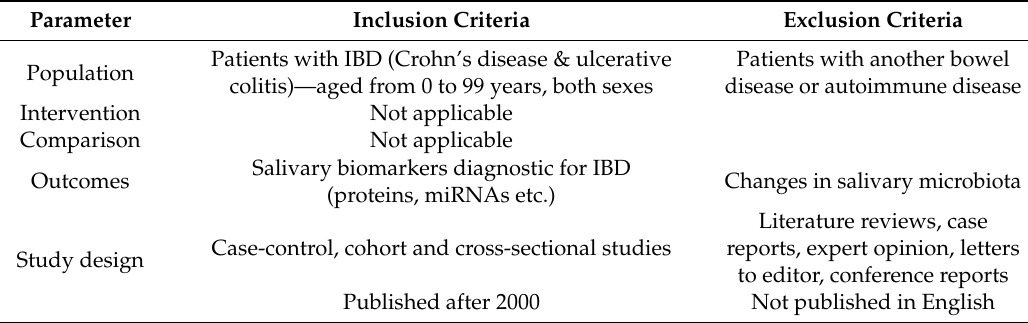
Table 4. Inclusion and exclusion criteria according to the